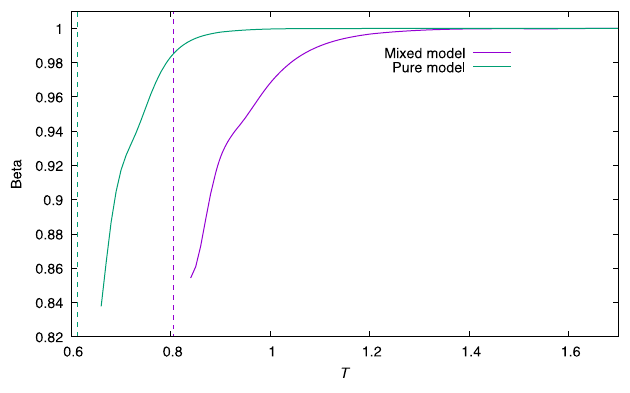
ˆ β FIG. 23. The stretching exponent as a function of temperature in the mixed ( 3 þ 4 )-spin model and in the pure three-spin model. The vertical lines correspond to the transition temperatures T MCT of the two models. We see no qualitative differences between the two cases. Moreover, in the case of the mixed model, deviations from pure exponential behavior are seen much above the onset ≃ 0 . 91 temperature T onset